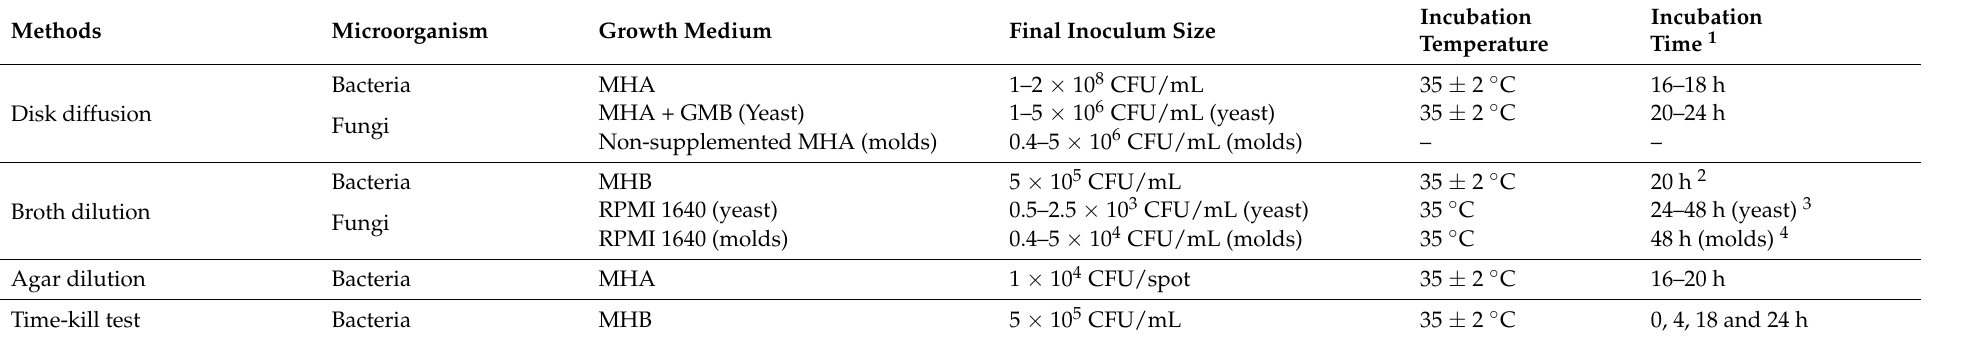
Table 9. Experimental conditions for antimicrobial susceptibility testing methods as recommended by CLSI (Adapted from